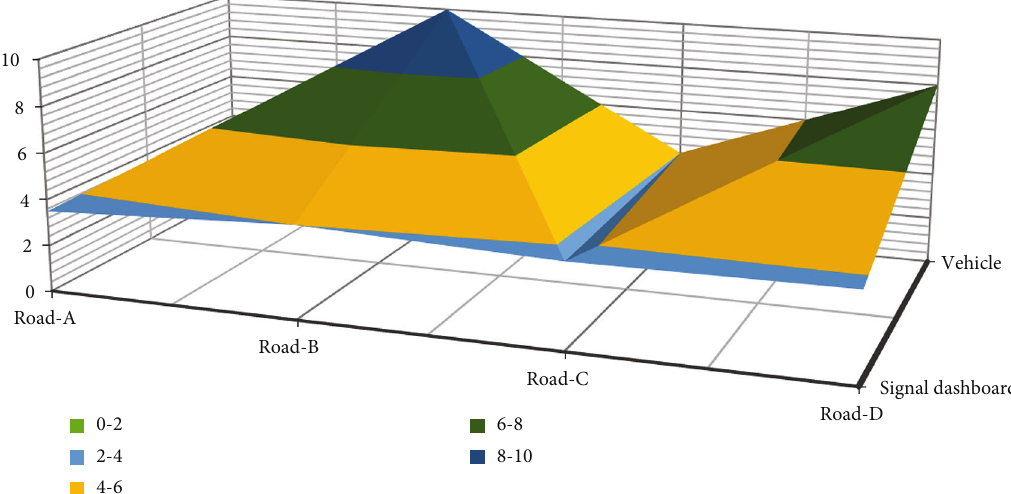
Figure 9: Vehicle vs. sync time(s) (sensor to signal